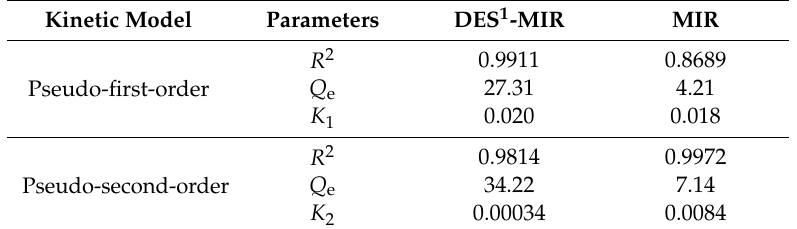
Table 4. Parameters of OFL adsorption towards DES 1 -MIR and MIR from two kinetic